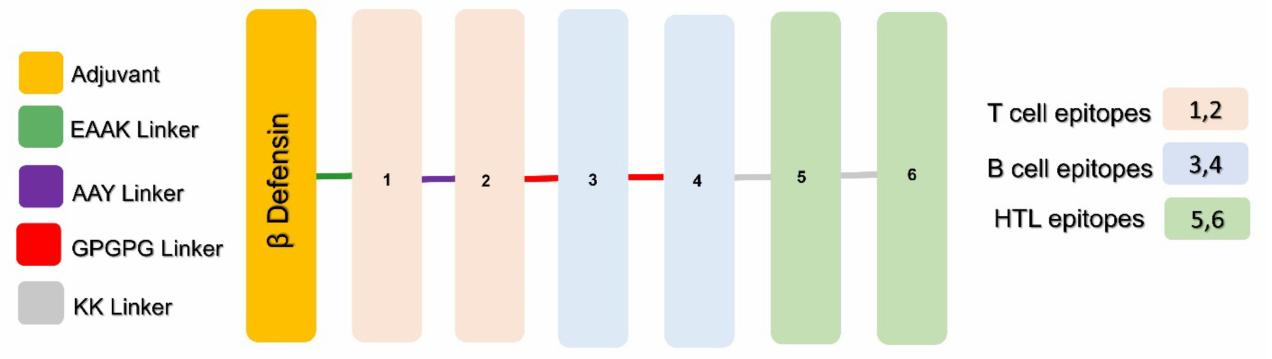
Figure 2. Showing the topographical organization of adjuvant, epitopes, and linkers in each of the designed